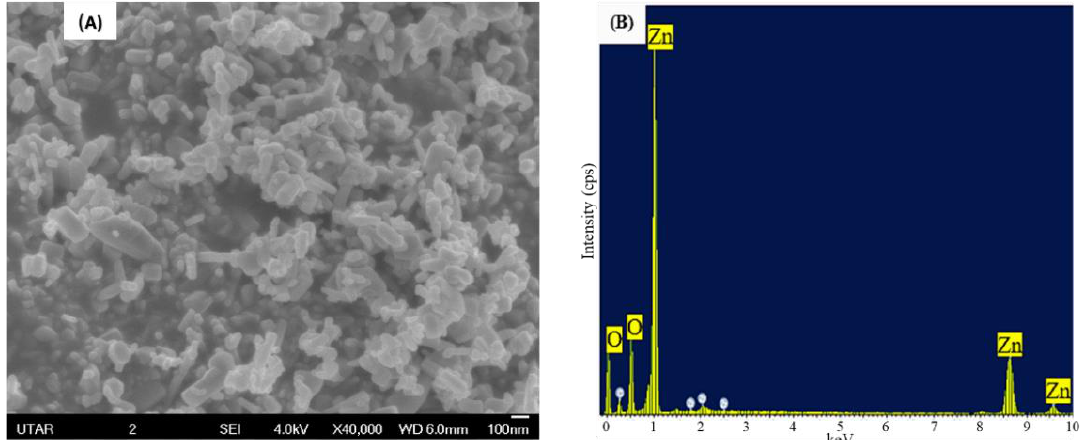
Figure 1. Surface morphology and elemental composition of ZnO NPs; SEM ( A ) and EDX spectrum ( B ).